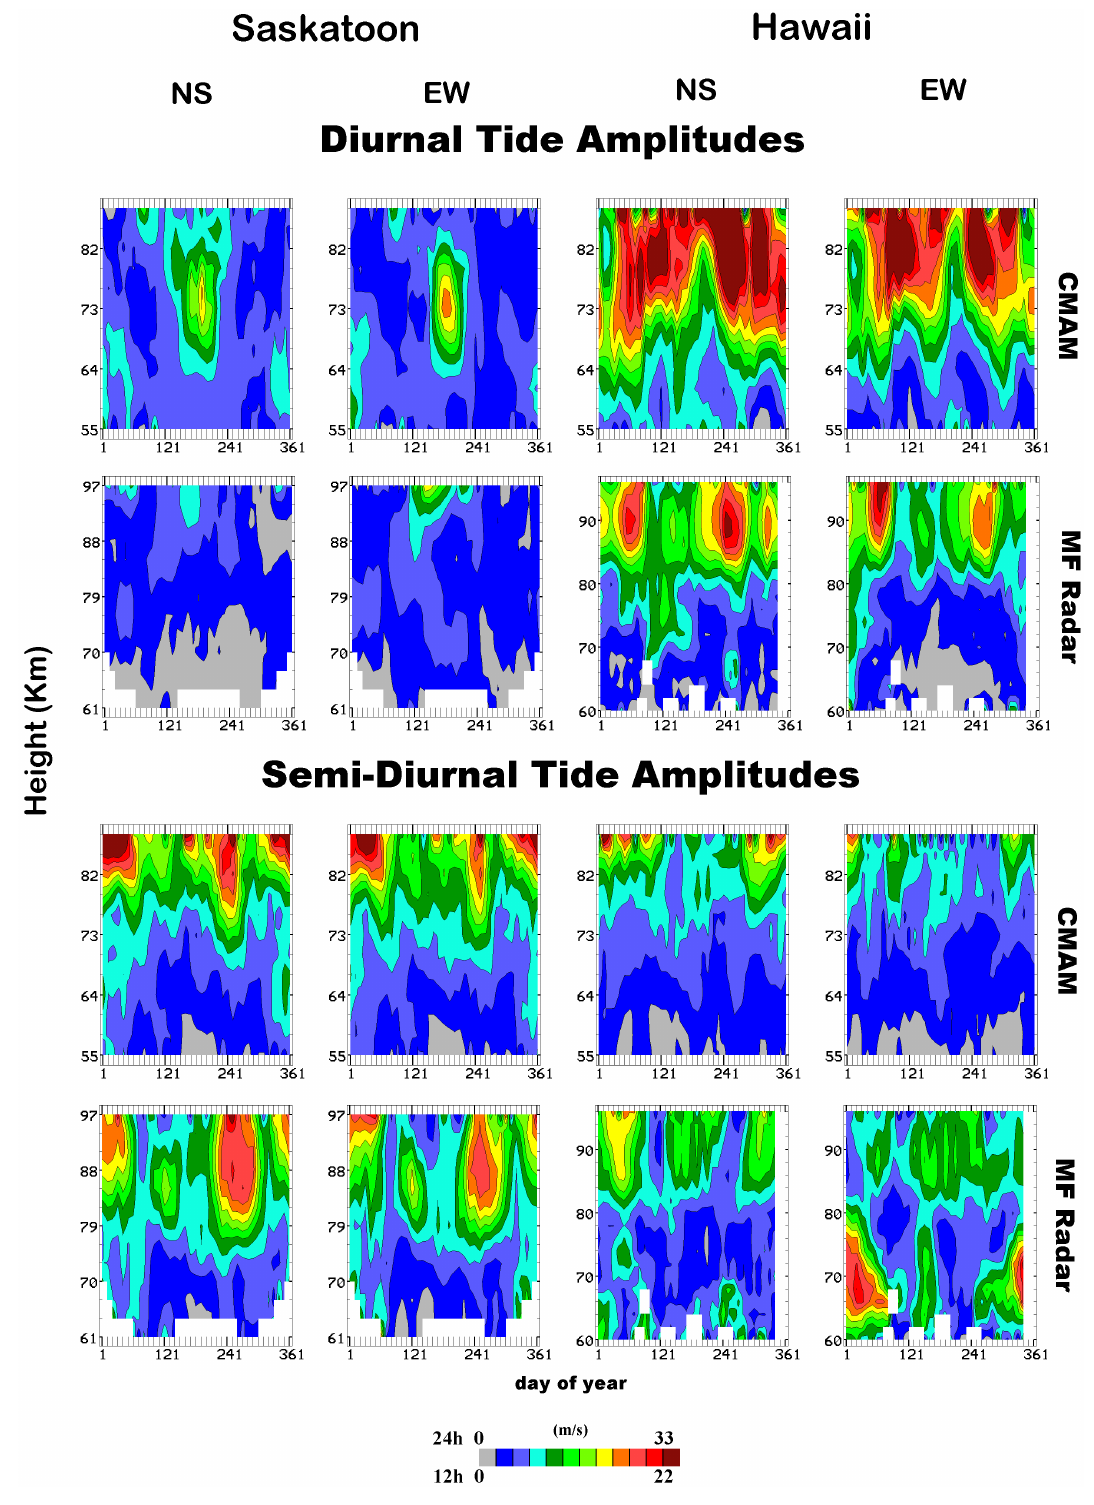
Fig. 5. Annual contour plots (height versus time) of diurnal and semi-diurnal tidal amplitudes resulting from harmonic analysis of CMAM (year 31) and MF (year 2001) radar data for Saskatoon (52 ◦ N) and Hawaii (22 ◦ N), and providing 10-day resolution. Interpolation between data points employs a “bilinear patch” (Sect. 2.4). Zonal (EW) and meridional (NS) components are